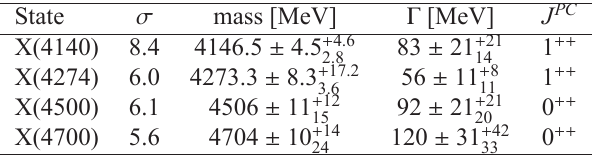
Table 1. Parameters of four resonant states decaying to J / Ψ φ .